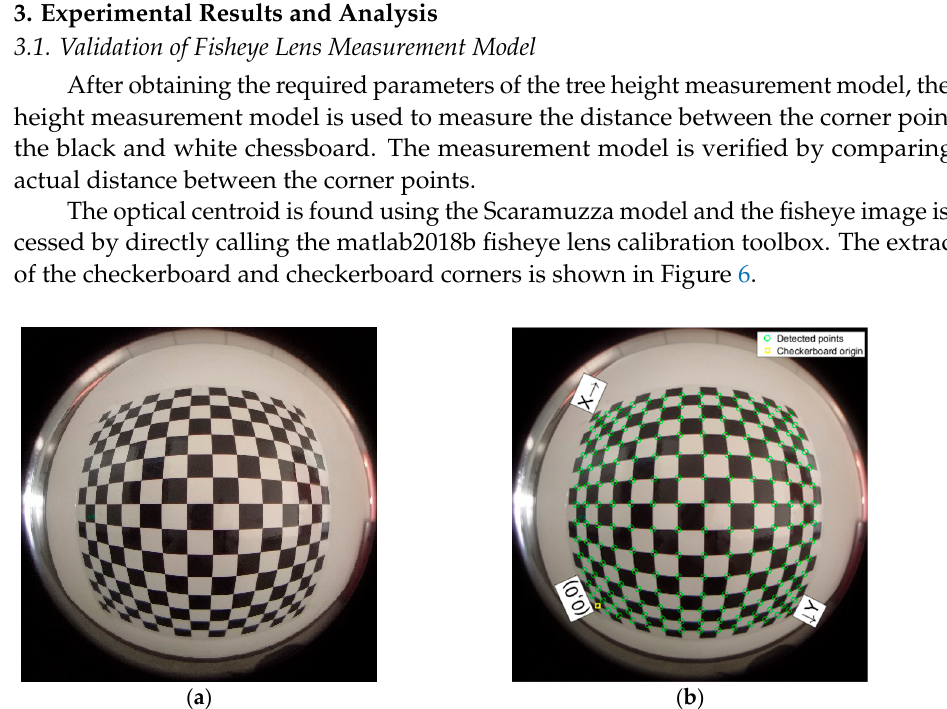
Figure 7. Corner point position selection and calibration plate position selection. ( a ) Corner point position, A , B , C , and D are corner points; ( b ) Five positions of the calibration plate. Three sets of distances, AB , AC , and AD , were taken on the chessboard, the error was analyzed, and the accuracy of the measurement model was verified. Table 1 shows the calculation results of the distance between AB , AC , and AD .